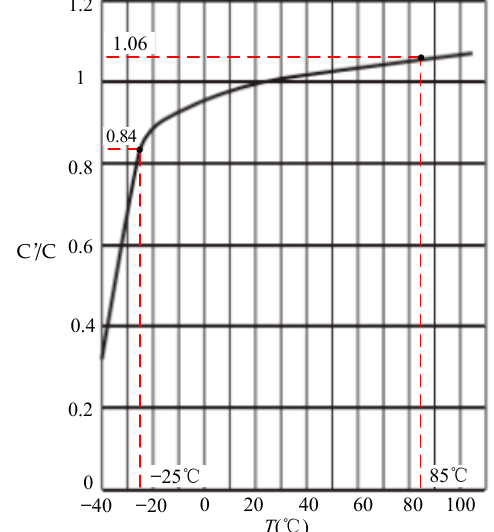
Figure 5. Temperature characteristics of aluminum electrolytic